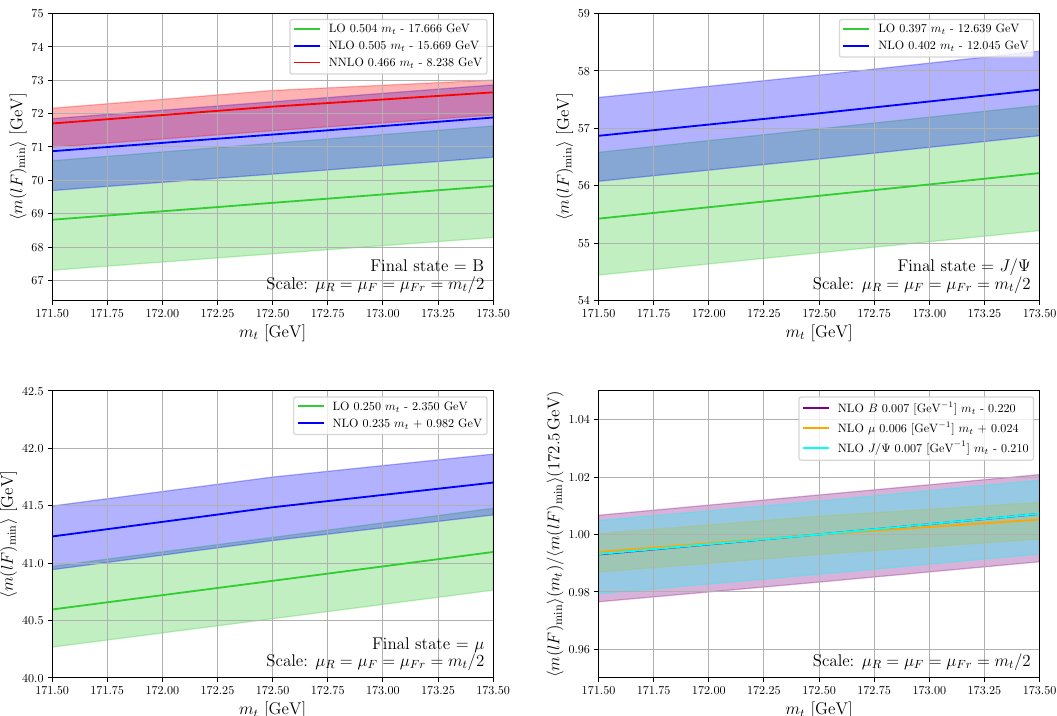
Figure 14 . The first moment of the normalized m ( F‘ ) min distribution for F = B (upper left), F = J/ψ (upper right) and F = µ (lower left). Shown are the LO, NLO and NNLO predictions as a function of m (only the LO and NLO ones for F = J/ψ, µ ). Bands at each order denote 15-point t scale variation for the fixed scale (3.2). The three NLO curves, divided by their respective central scale values at m = 172 . 5 GeV, are shown together in the lower-right t